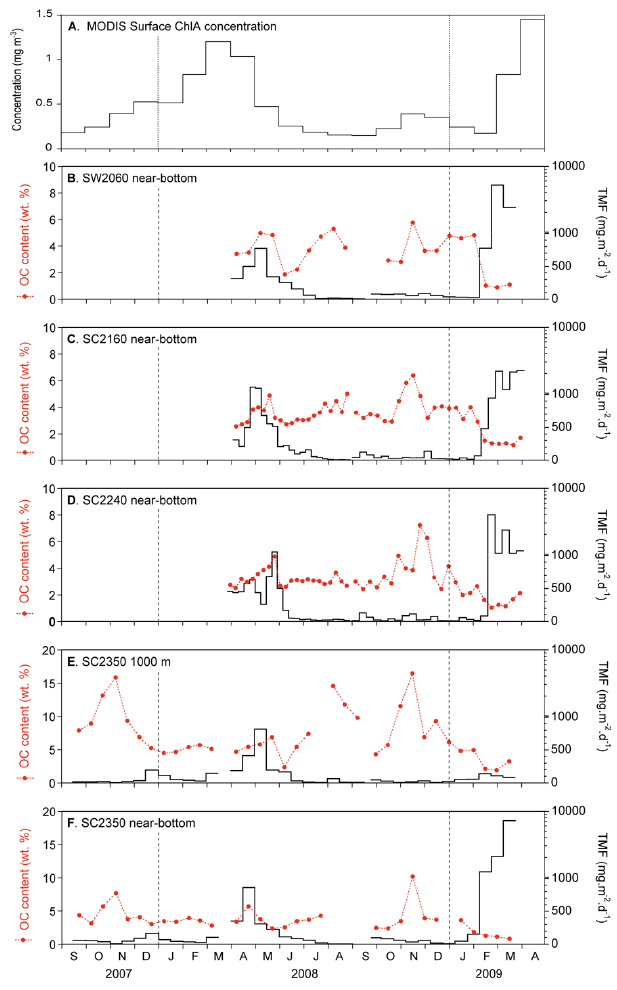
Fig. 8. Time series of monthly averaged sea surface chl a concen- tration (in mgm − 3 ) in the OOC region (A) , total mass fluxes (TMF, in mgm − 2 d − 1 ) and particulate organic carbon (POC contents, in % of dry weight) at few tens of meters above seabed for SW2060 (B) , SC2160 (C) , SC2240 (D) , and SC2350 (F) , and at mid-depth for SC2350 (E) from September 2007 to April